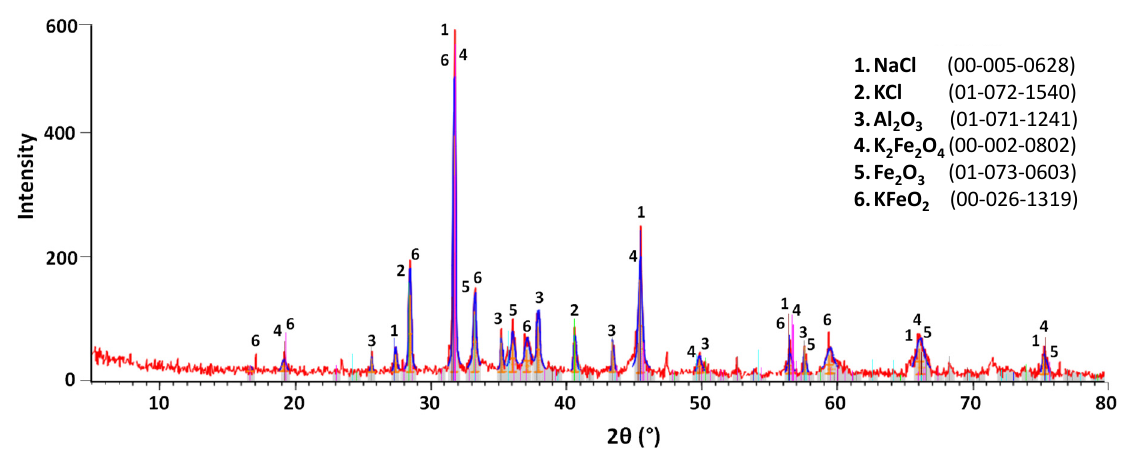
Figure 9. Mineralogical phases (XRD patterns) of raw salt slag.